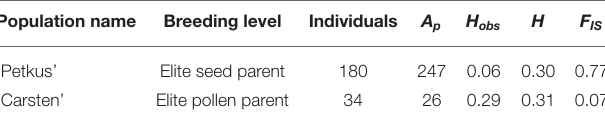
TABLE 3 | Analysis of molecular variance (AMOVA) for the total breeding